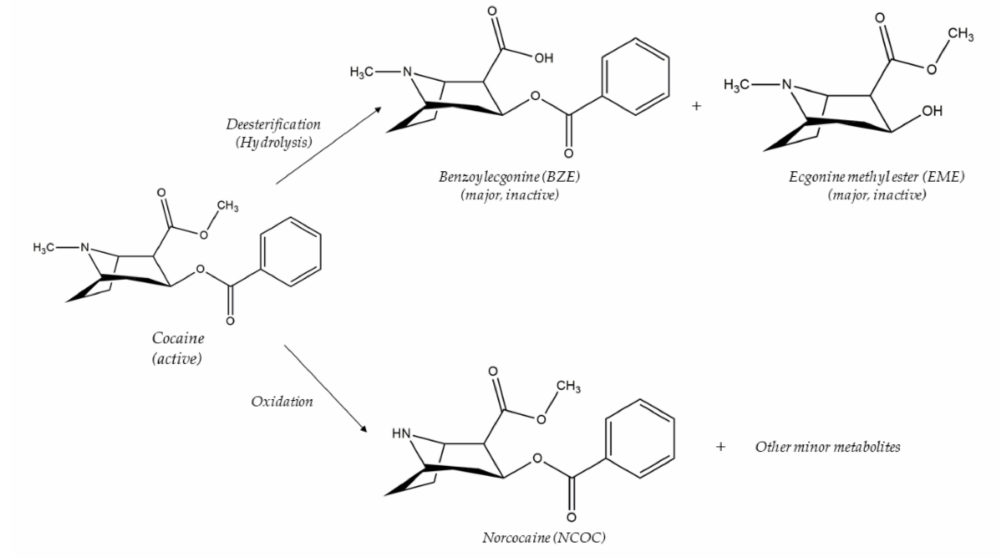
Figure 6. Cocaine